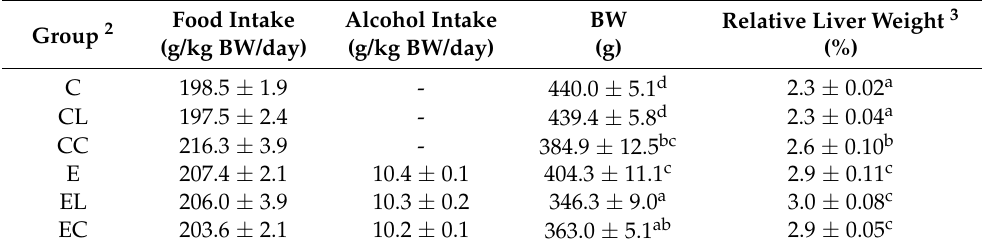
Table 3. Effects of different dietary fat sources on food intake, alcohol intake, body weight (BW), liver weight, and relative liver weight in rats 1